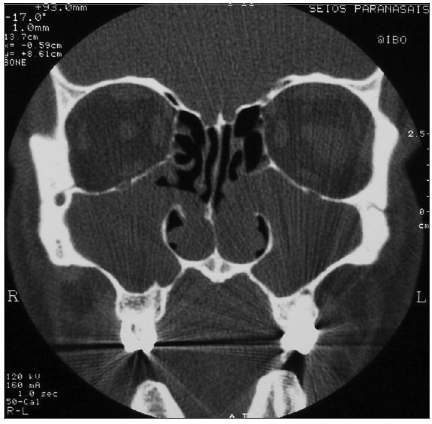
Figure 1. CT of the paranasal sinuses - coronal section showing tumors in both maxillary sinuses, which extend to the nasal cavity through the middle